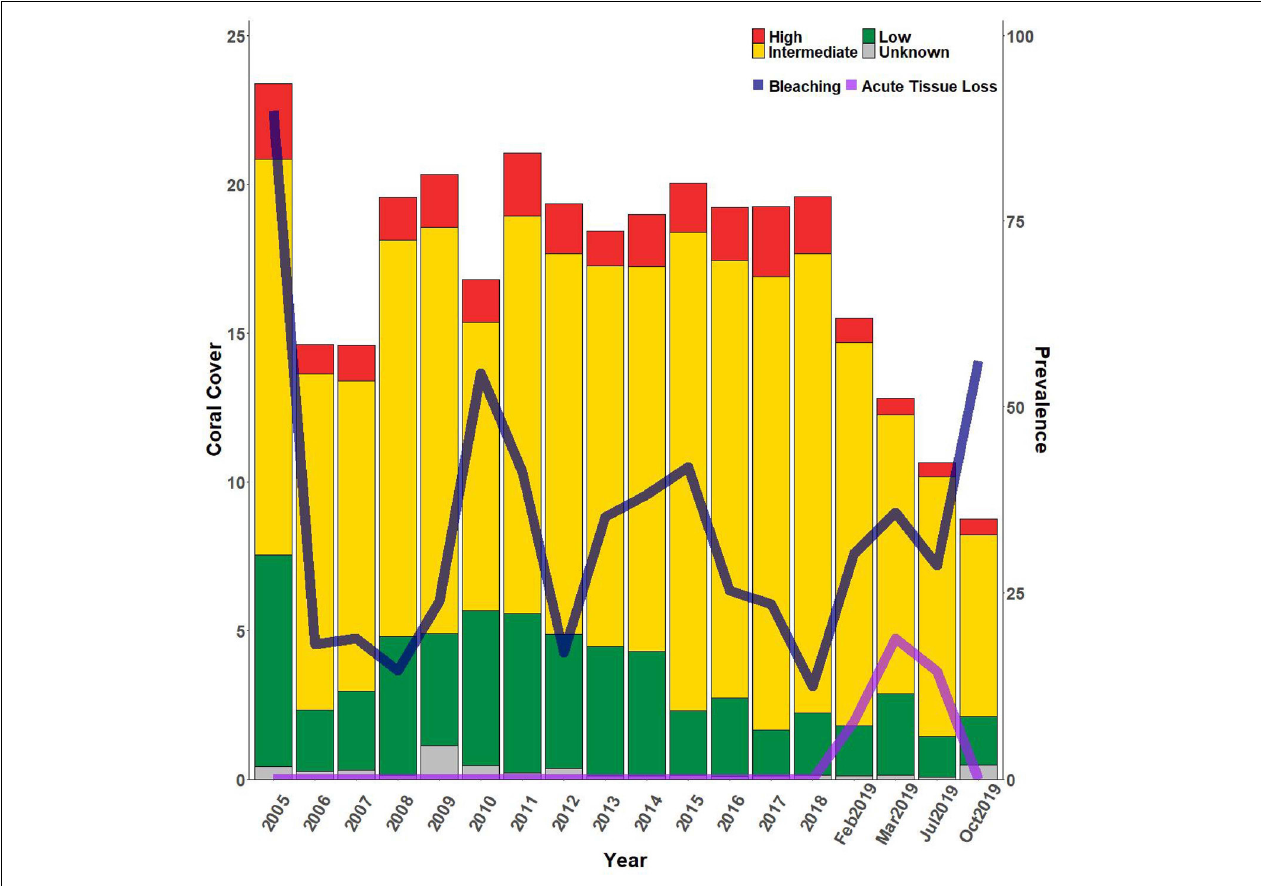
FIGURE 8 | Relative percent coral cover changes at FC reef with bleaching and acute tissue loss disease. Bars indicate % cover of high, intermediate, low, and unknown SCTLD susceptibility corals where classifications of susceptibility are based on the NOAA SCTLD case description. Whole bars represent total coral cover. Lines indicate percent prevalence (# corals affected/total # corals) of acute tissue loss due to disease (light purple line) and bleaching (dark purple line). SCTLD was first observed at FC on January 29,